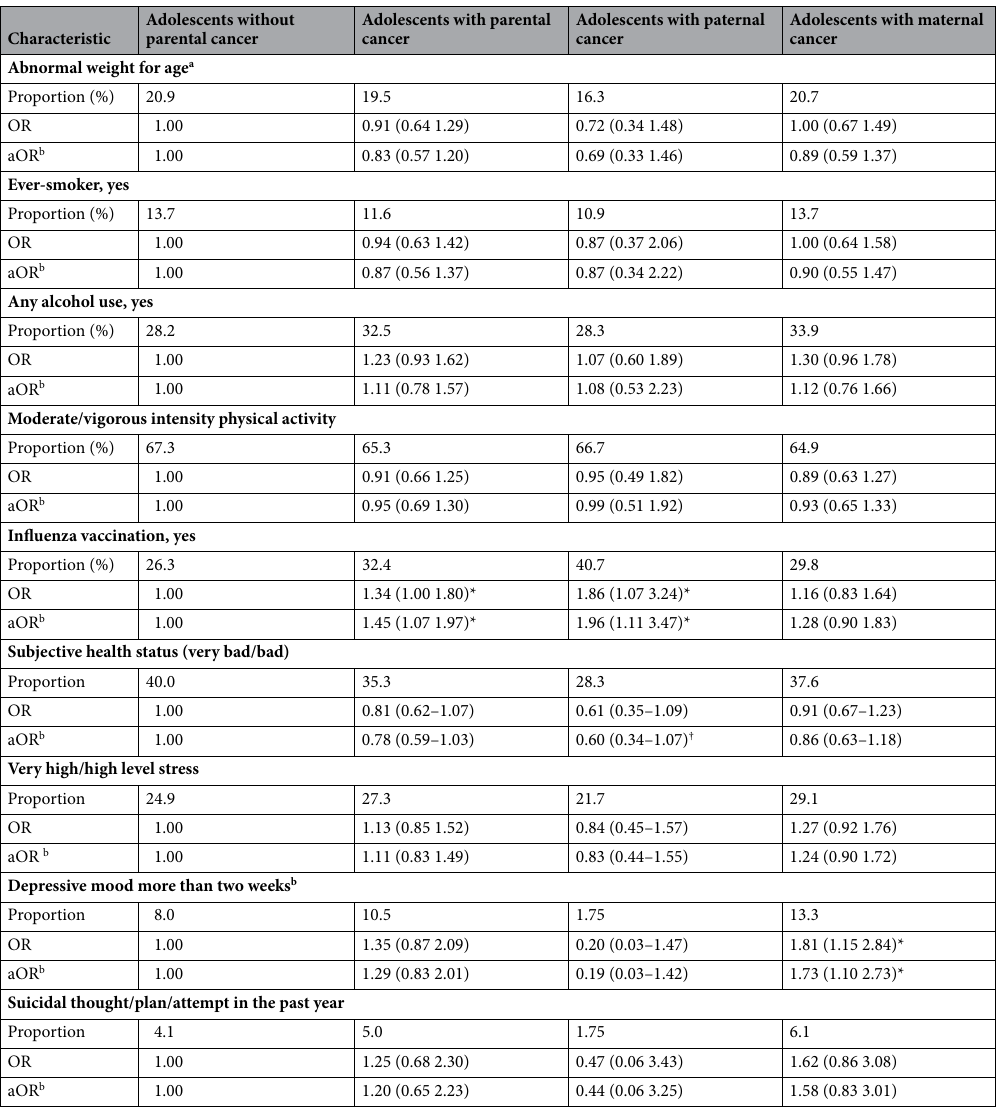
Table 2. Behavioral risk factors and psychological factors among adolescent with or without parental cancer. Data are presented as percentages (%) and odds ratio (95% CI). OR odds ratio; CI confidence interval. a Abnormal weight for age was defined as ≥ 95percentile or < 5percentile of weight for age of Korean adolescent population. b Adjusted for age, sex, and household monthly income. c Recommended physical activity (150 min/ week of moderate-intensity physical activity, or 75 min/week of vigorous-intensity physical activity, or the equivalent dose of moderate and vigorous physical activity). * P <